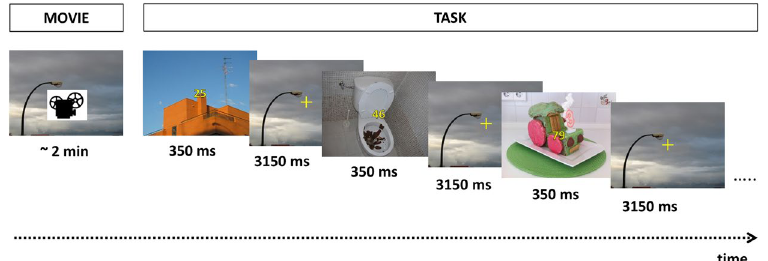
Figure 5. Schematic illustration of the task (this example shows the neutral block preceded by the neutral movie fragment). Note that these example pictures were not among the experimental